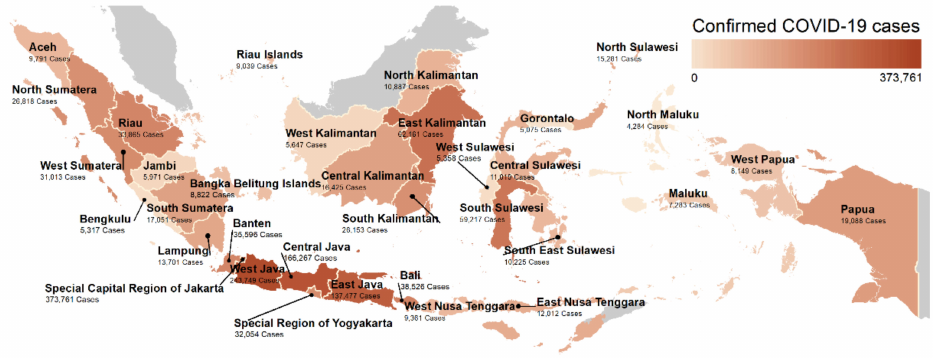
Figure 1. Cumulative cases of COVID-19 in 34 provinces. Source: [32] accessed on 23 March